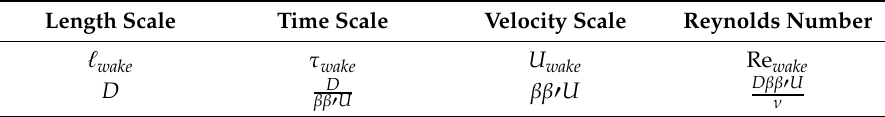
Table A3. Characteristic wake scales in VAWT turbines.